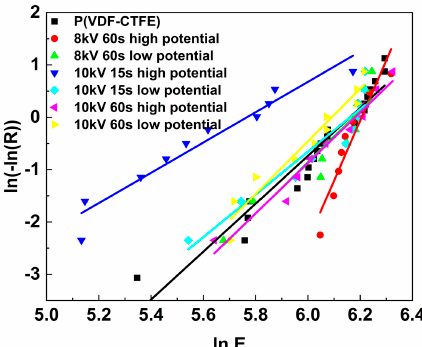
Figure 5. Weibull analysis of the dielectric breakdown strength data of the P(VDF-CTFE) film and the DBD-treated films. For the treated films, breakdown tests were performed with the treated surface connected to either the high potential or low potential side of the power supply. Table 1. The dielectric breakdown strength of the pristine P(VDF ‐ CTFE) film and the film treated under different conditions. (Unit: MV/m).